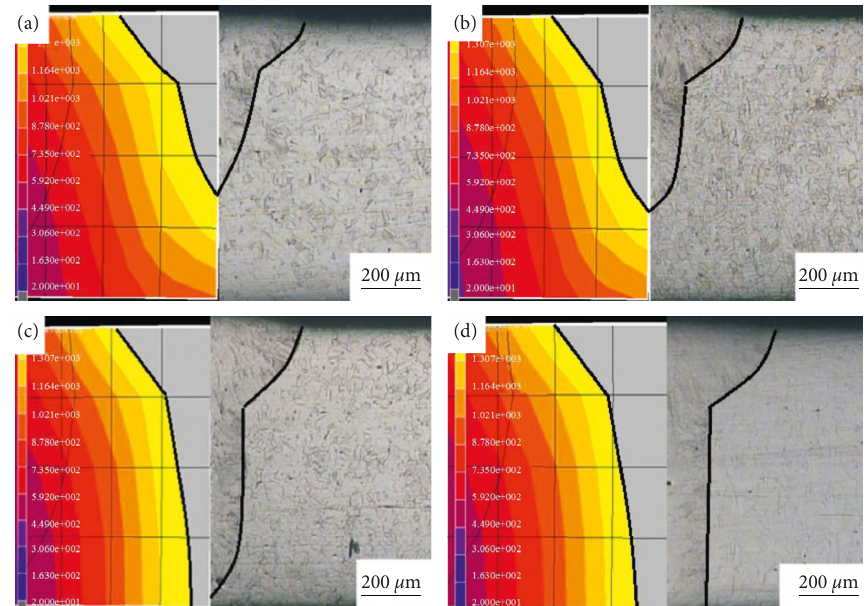
Figure 12: The comparison of experimental and simulation results of the weld profile for different laser powers in surfacing welding: (a) 200 W, (b) 250W, (c) 300W, and (d)